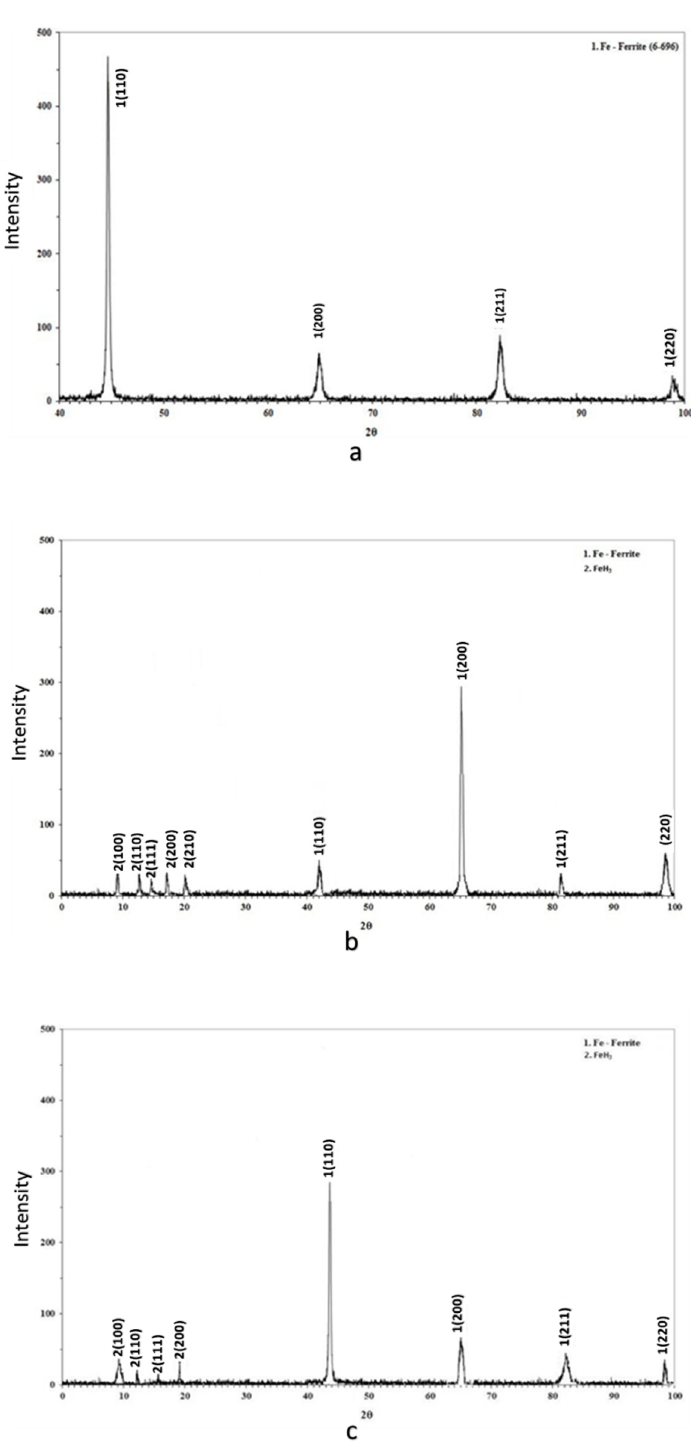
Figure 11. Identification of phases by X-Ray Diffraction patterns ( a ) for the uncharged condition; ( b , c ) after cathodic polarization at 10 and 20 mA/cm 2 current density.